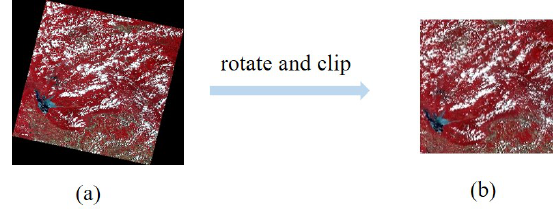
Figure 7. The resultant image ( b ) that was obtained by processing the original image ( a